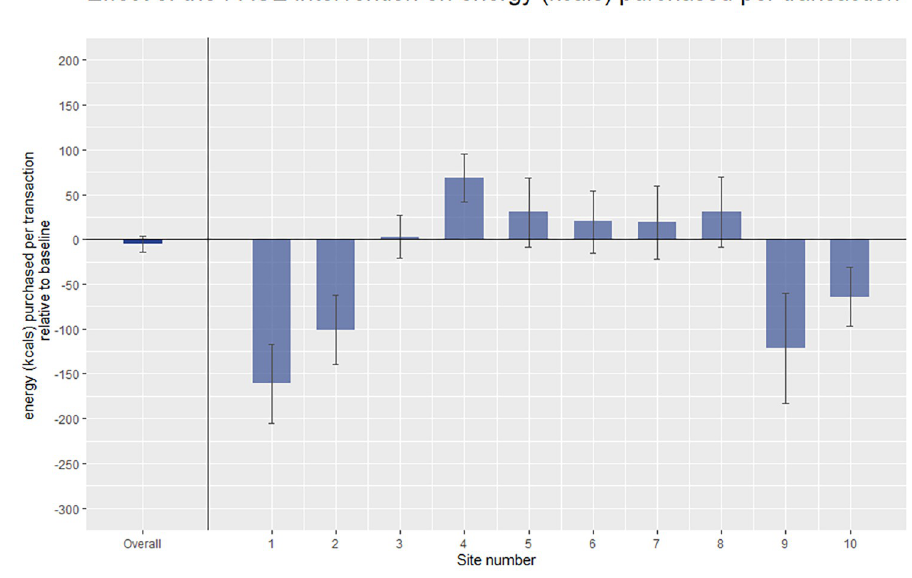
Fig 4. The effects PACE on energy (kcals) purchased per transaction relative to baseline. Error bars represent 95% confidence intervals for the overall effects and 99.5% confidence intervals (Bonferroni adjustment) for the by-cafeteria